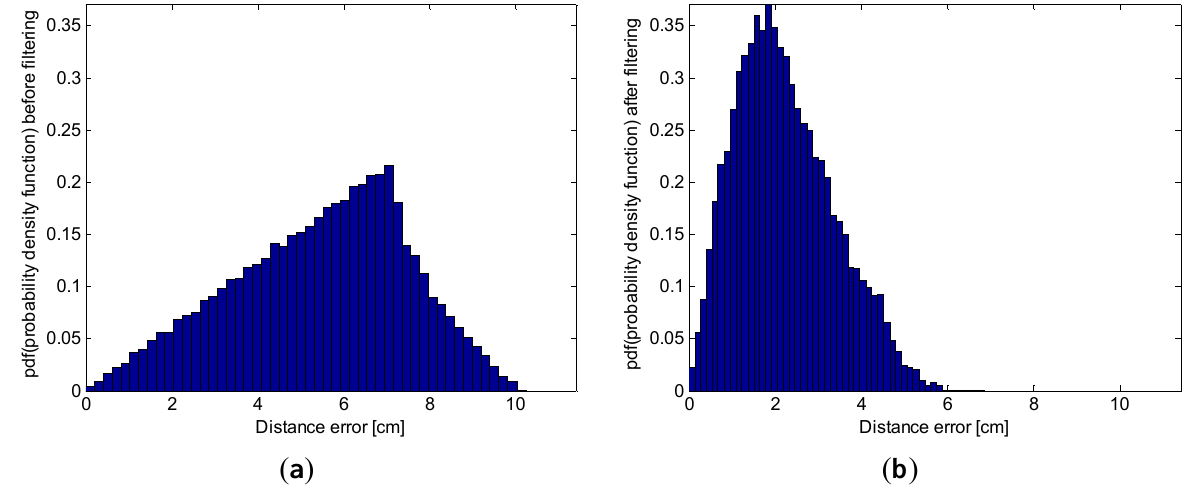
Figure 11. Histogram of distance errors, with 5 Hz update rate, using the simulations along the 18 straight lines shown in Figure 7a. ( a ) before applying the Kalman filter; ( b ) after applying the Kalman filter. The histogram has been normalized so that it has a unitary area, representing an approximation to the probability density function ( pdf ) of the distance errors statistical random variable.